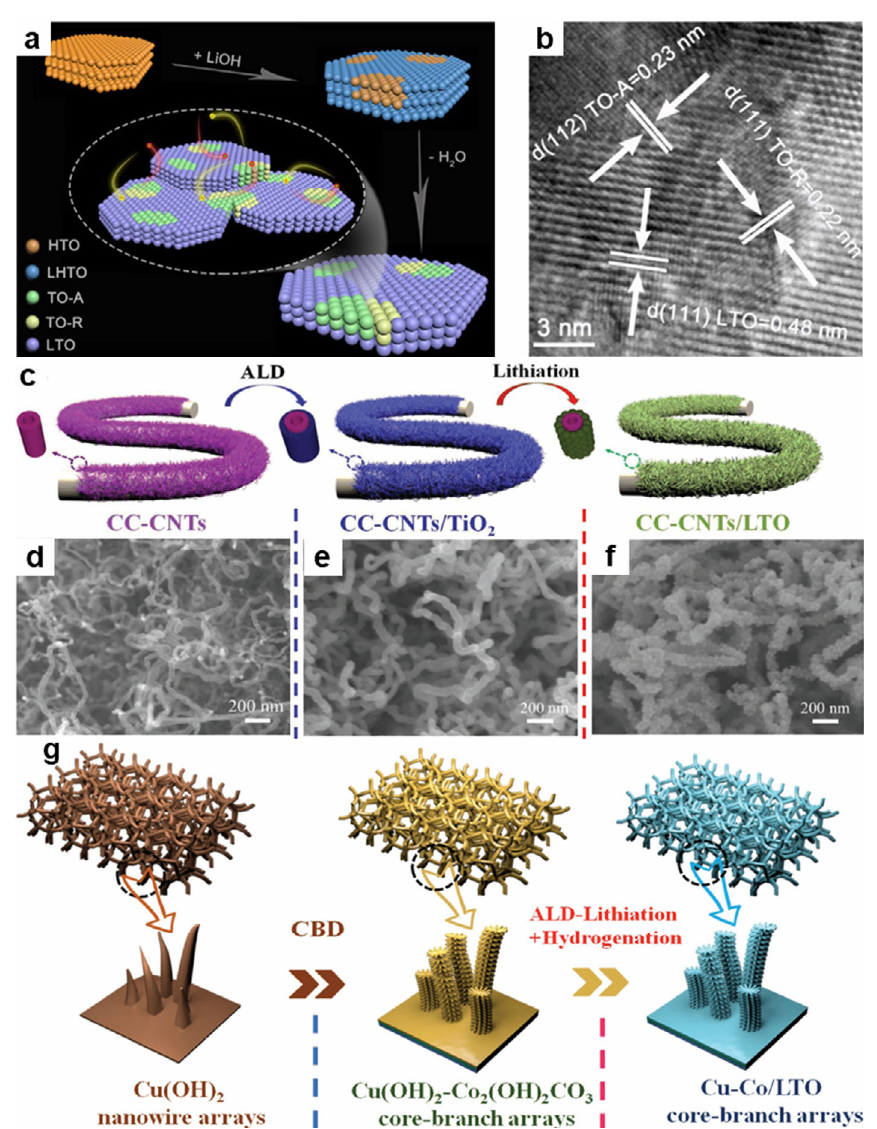
Fig. 3 Recent progress of Li 4 Ti 5 O 12 materials. (a) Schematic diagram and (b) HRTEM image of the synthesis procedure of Li 4 Ti 5 O 12 /anatase TiO 2 /rutile TiO 2 . Reproduced with permission from Ref. [42], © Elsevier Ltd. 2017. (c) Schematics and (d–f) SEM images of the synthesis procedure of carbon cloth (CC)-CNTs/Li 4 Ti 5 O 12 arrays. Reproduced with permission from Ref. [44], © John Wiley and Sons 2018. (g) Illustration of synthesis of Cu–Co/Li 4 Ti 5 O 12 core–branch arrays. Reproduced with permission from Ref. [47], © John Wiley and Sons